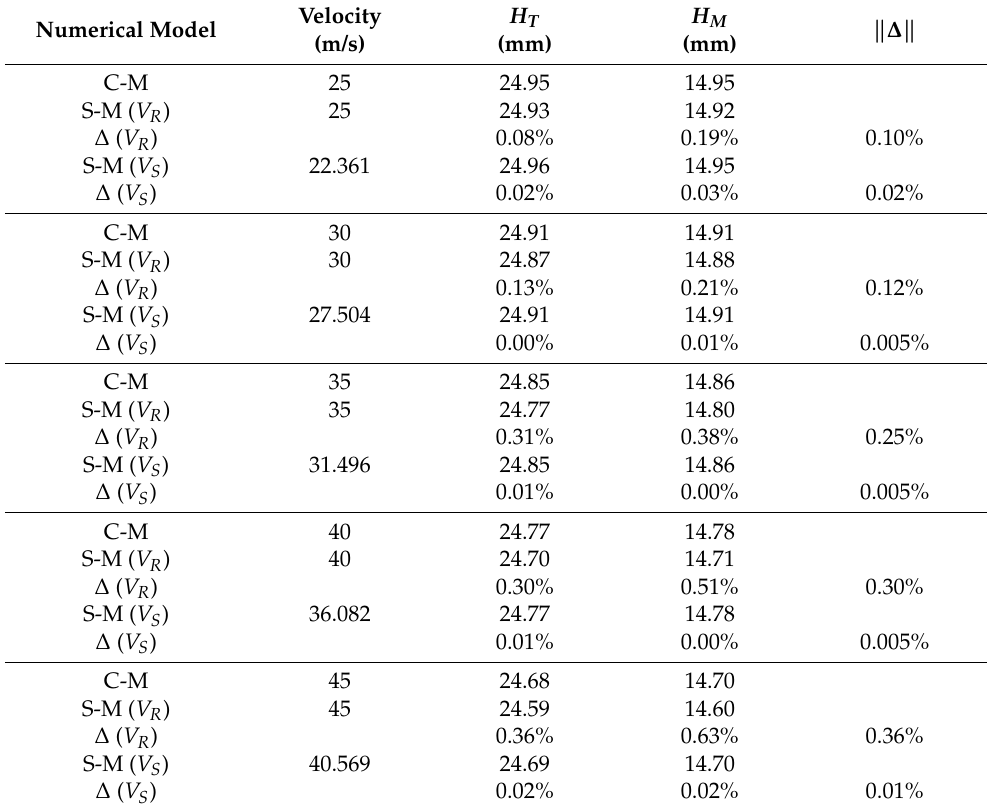
Table 8. Identification of the equivalent impact velocity for the simplified model of dynamic shear